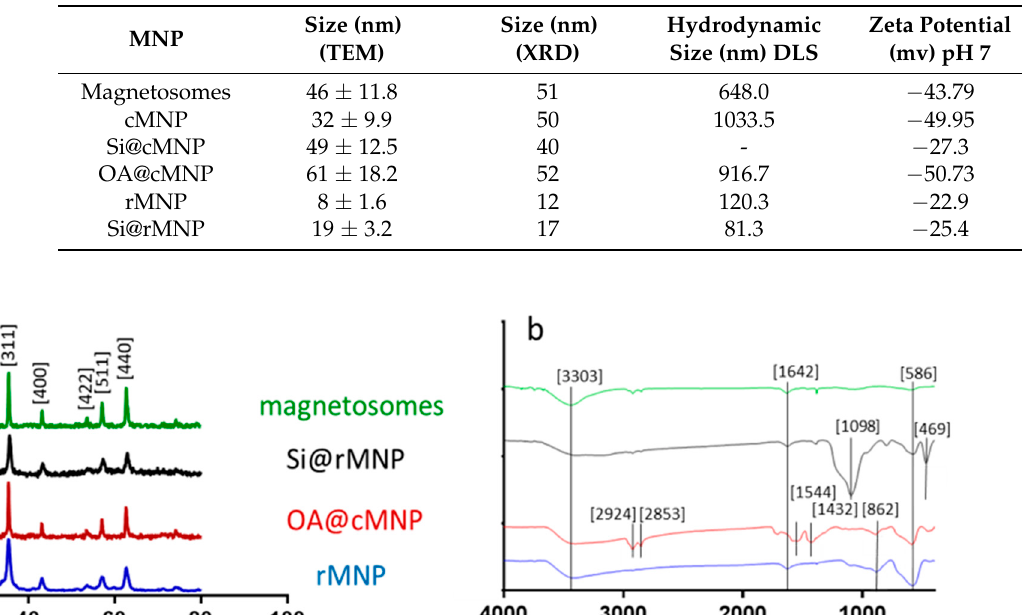
Table 2. Characterization data for all MNP, sizing data for TEM obtained from gaussian fit (Figure 3a) of histograms for each sample with standard deviation (Supplementary Figure S1). Dynamic light scattering (DLS) data are shown in Supplementary Figure S2.